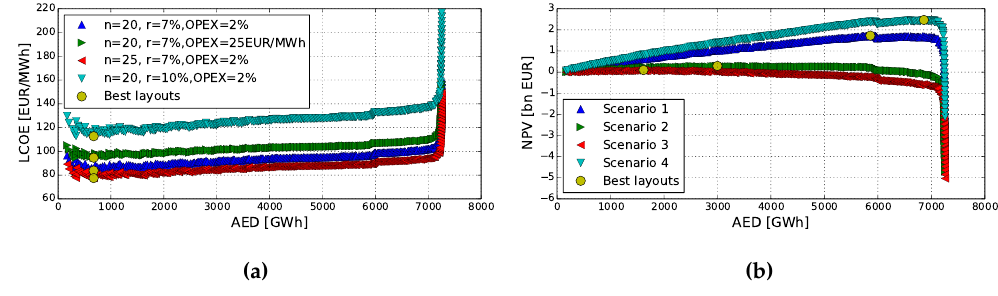
Figure 20. LCOE and NPV values for different economic factors. ( a ) LCOE; ( b )